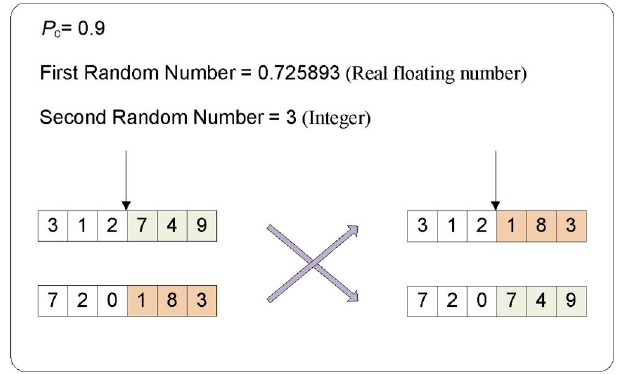
Figure 4: An example of Cross